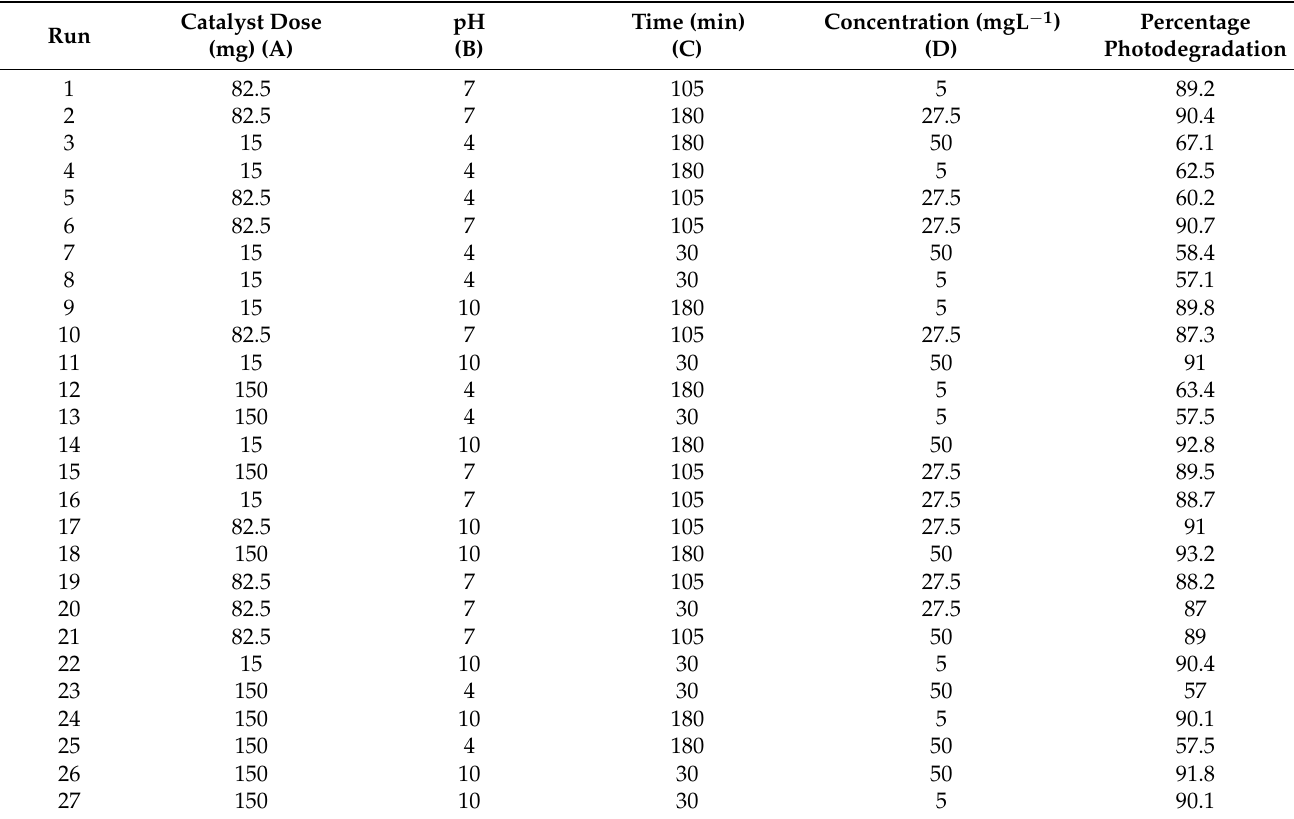
Table 1. Experimental sets to evaluate inter parameter dependence using face centered approach of